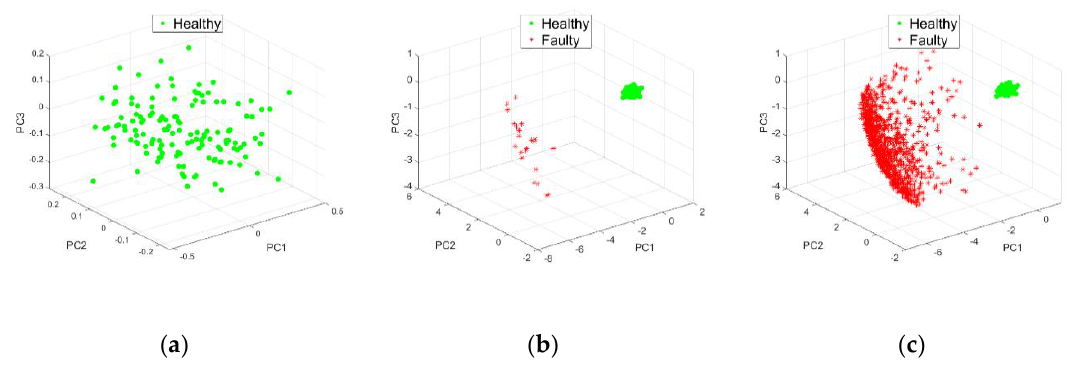
Figure 4. Effect of amplitude 0.1 b (t) : ( a ) 𝐴 10 , ( b ) 𝐴 11 and ( c ) 𝐴 51 .